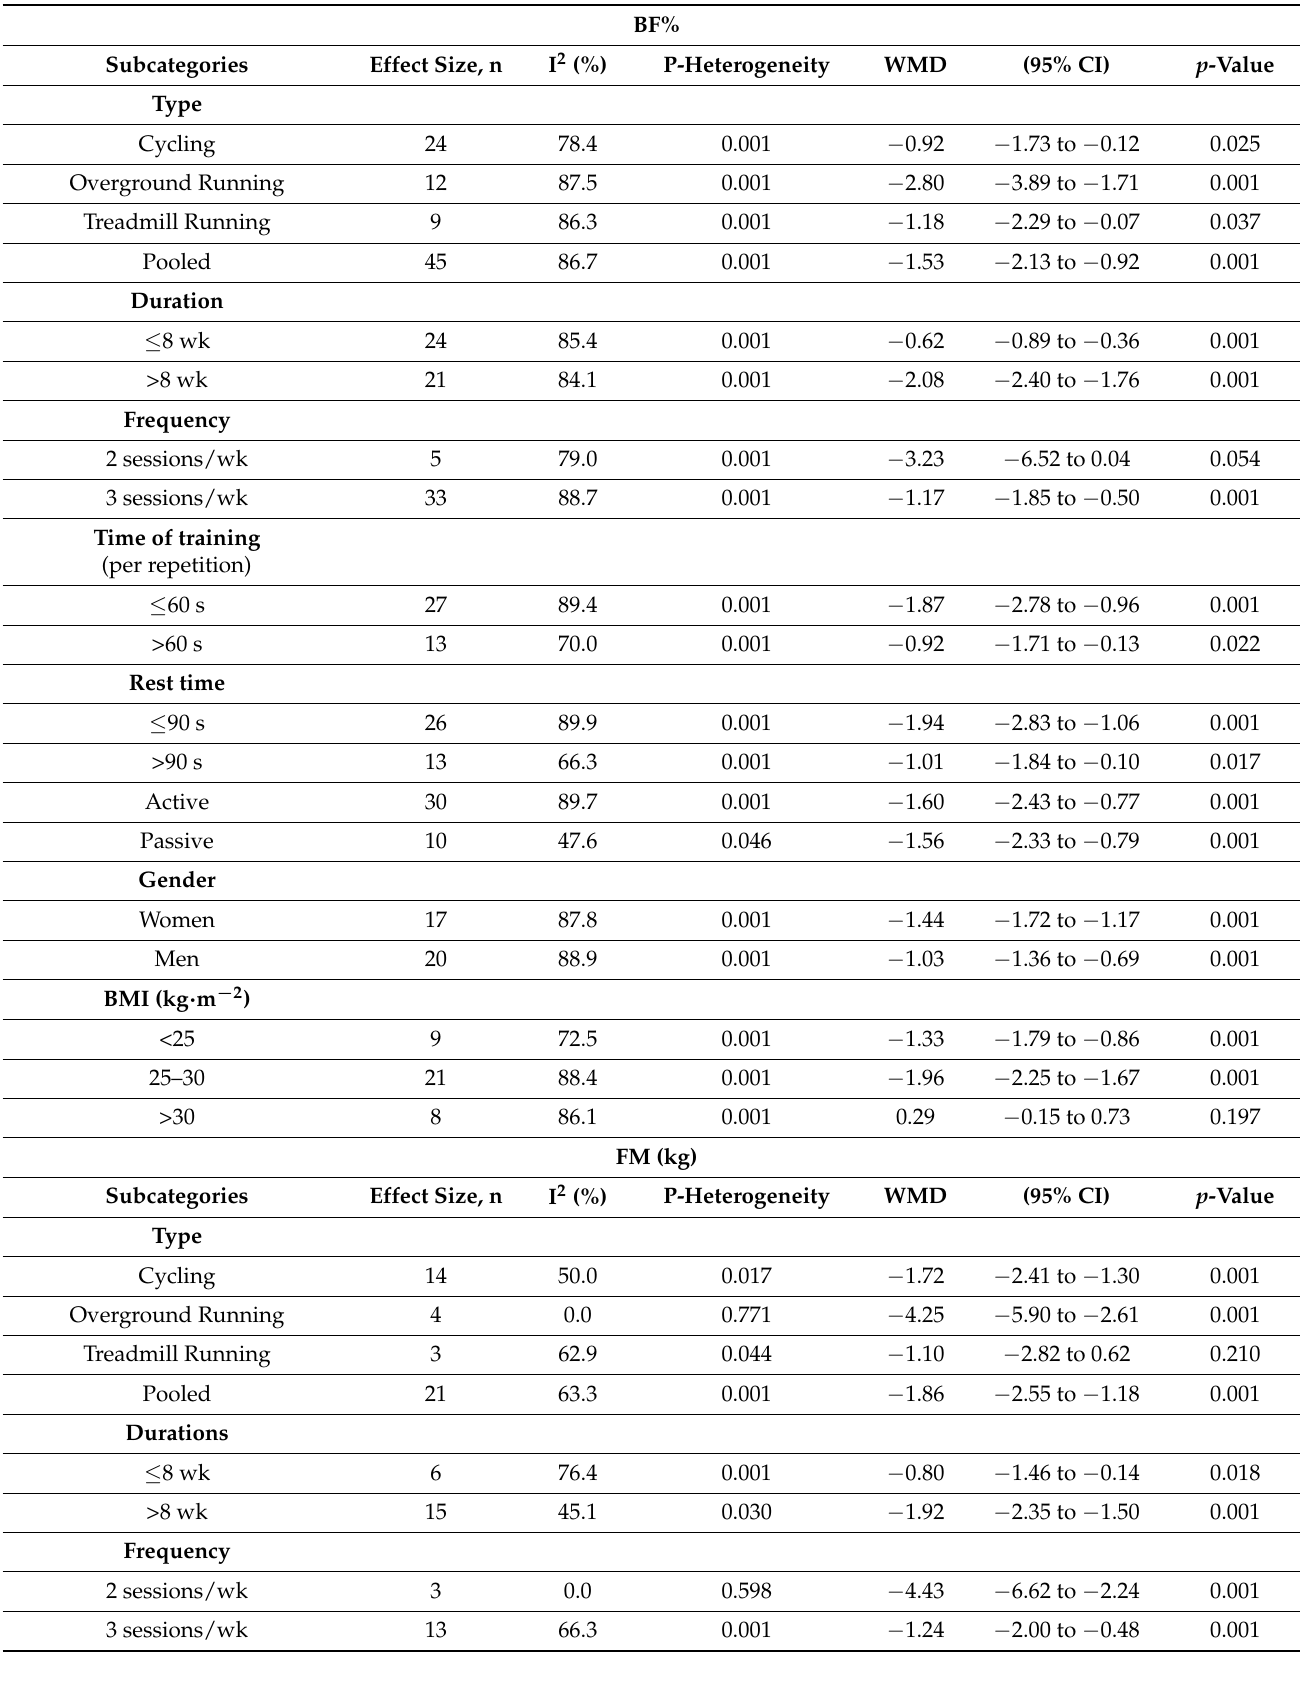
Table 3. Subgroup analysis of HIIT on BF%, FM, and